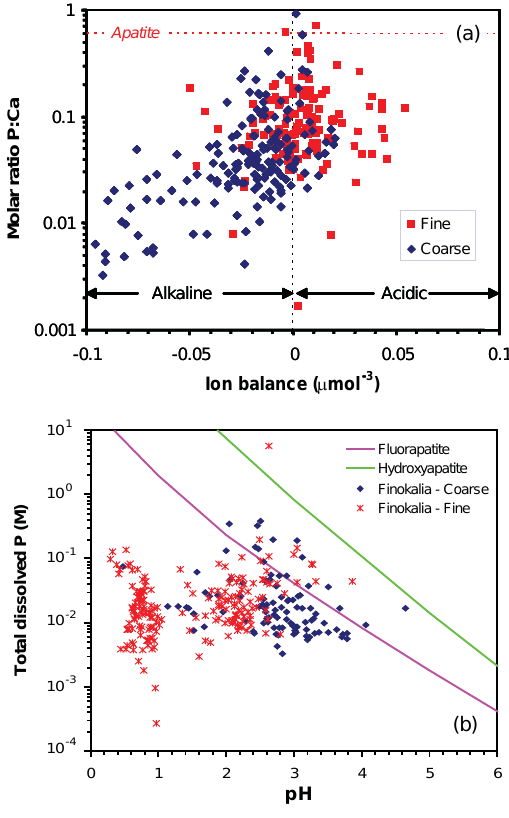
Fig. 2. (a) The molar ratio of LIP over Ca as a function of ion balance, I b . Fine fraction samples are shown with magenta sym- bols, coarse particles with blue symbols. Also shown is the P:Ca ratio for the mineral apatite. (b) Predicted concentration of total dissolved P against aerosol pH. Predictions are carried out using the ISORROPIA-II thermodynamic model (Fountoukis and Nenes, 2007), assuming that the aerosol particles are at thermodynamic equilibrium with an ambient relative humidity (RH) of 95%, a temperature of 298K, and with aqueous compositions constrained from the observations. Also shown are the solubility lines for the end-member minerals fluorapatite, Ca 5 (PO 4 ) 3 F and hydroxya- patite, Ca 5 (PO 4 ) 3 OH. Repeating the calculations for lower RH de- creases pH, so that the aerosols become even more unsaturated with respect to the apatite minerals. For clarity only the solubility lines at ionic strength 3 m are